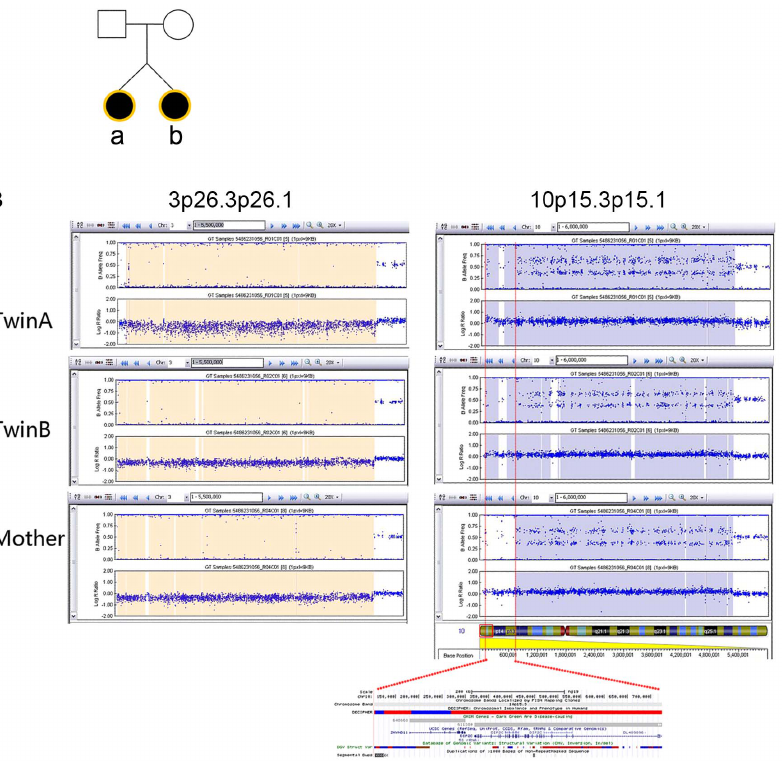
Figure 2. CNVs in the dizygotic twin sisters of Family 1. (A) Pedigree of family1 with dizygotic twins with PA. (B) Comparison of CNVs at 3p26.3-p26.1 and 10p15.3-p15.1 locus in twinA, twinB and the healthy mother. A minimal 620-kb duplication at 10p15.3 (chr10:103934-724229) was found in the twin sisters but not presented in the healthy mother. Annotated genes within this region are listed in the lower panel.